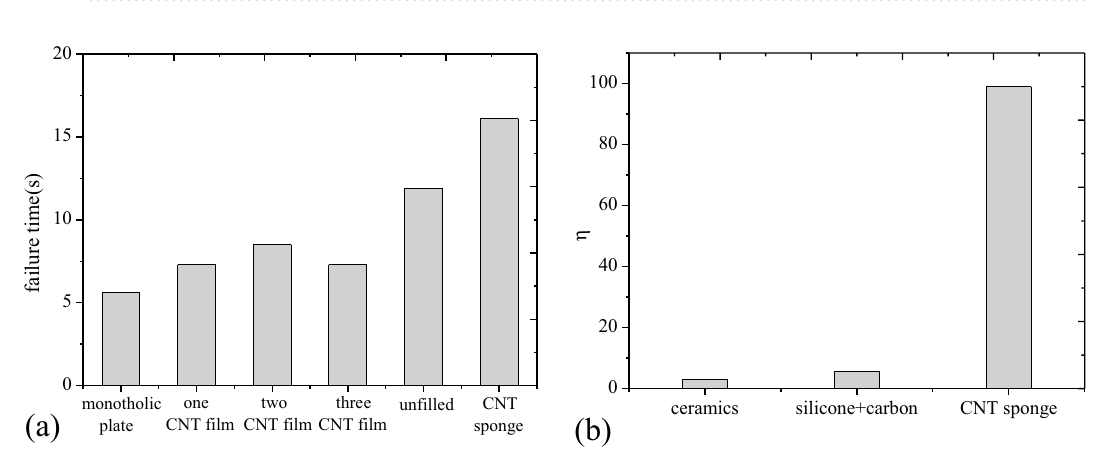
Figure 3. Effect of filler on the laser resistance of the sandwich panel. ( a ) Failure time, ( b ) ratio of increment of failure time to increment of structural weight due to addition of filler material. Laser irradiation behavior of the ceramic and the compound of silicone resin and carbon powder filled sandwich panel can be found in reference 9